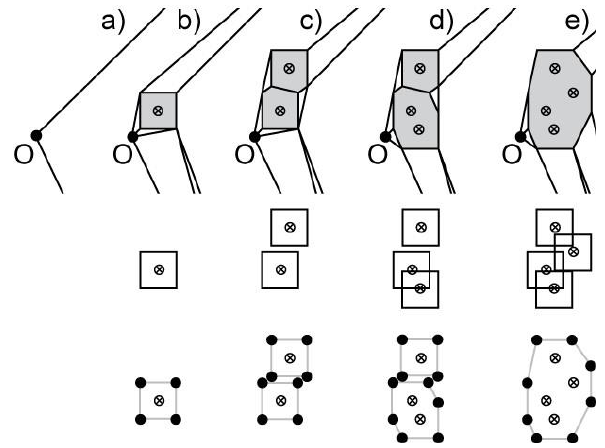
Figure 4: Obstacles in the navigable network: O – origin point, - obstacle points - additional nodes, grey area is excluded from navigation, a)-e) network update steps.